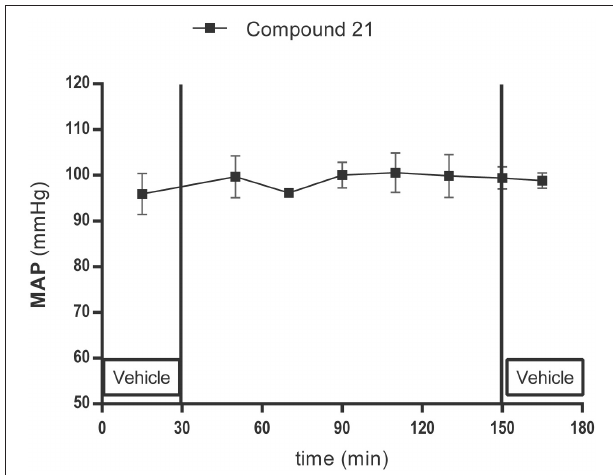
FIGURE 5 | Mean arterial pressure (MAP) measurement experiment: lack of effect of AT2R stimulation and infusion with the AT2R agonist C21(0.05 µ g/ µ l/h) in the PVN on MAP in normotensive anesthetized Wistar rats ( n = 5). MAP was recorded every 2s. C21 was dissolved in modified Ringer’s solution and administered through the dialysis probe from time 30 to 150 min. Data are shown as mean ± SEM. Statistical analysis for intragroup differences of the treatment is performed using one-way ANOVA for repeated measures and the Dunnett’s multiple comparison